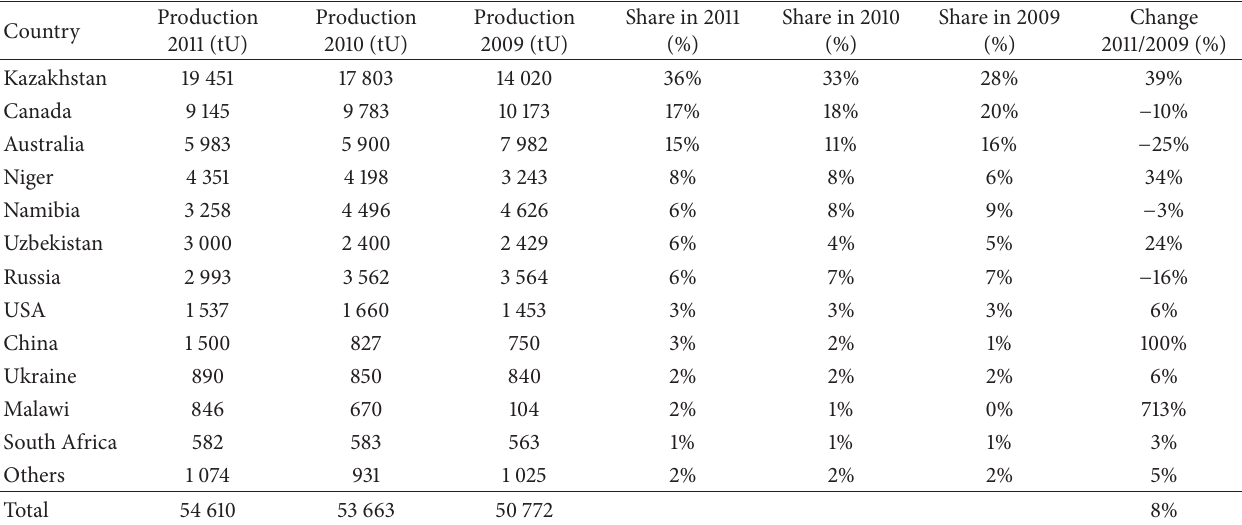
Table 3: Natural uranium production in 2010, compared with 2009 (tons of